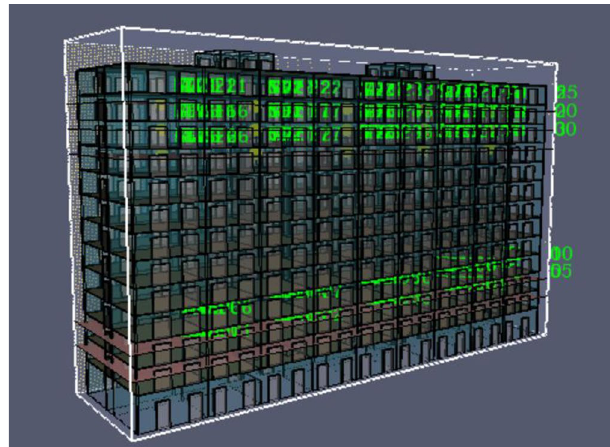
Figure 3. PyroSim model diagram.